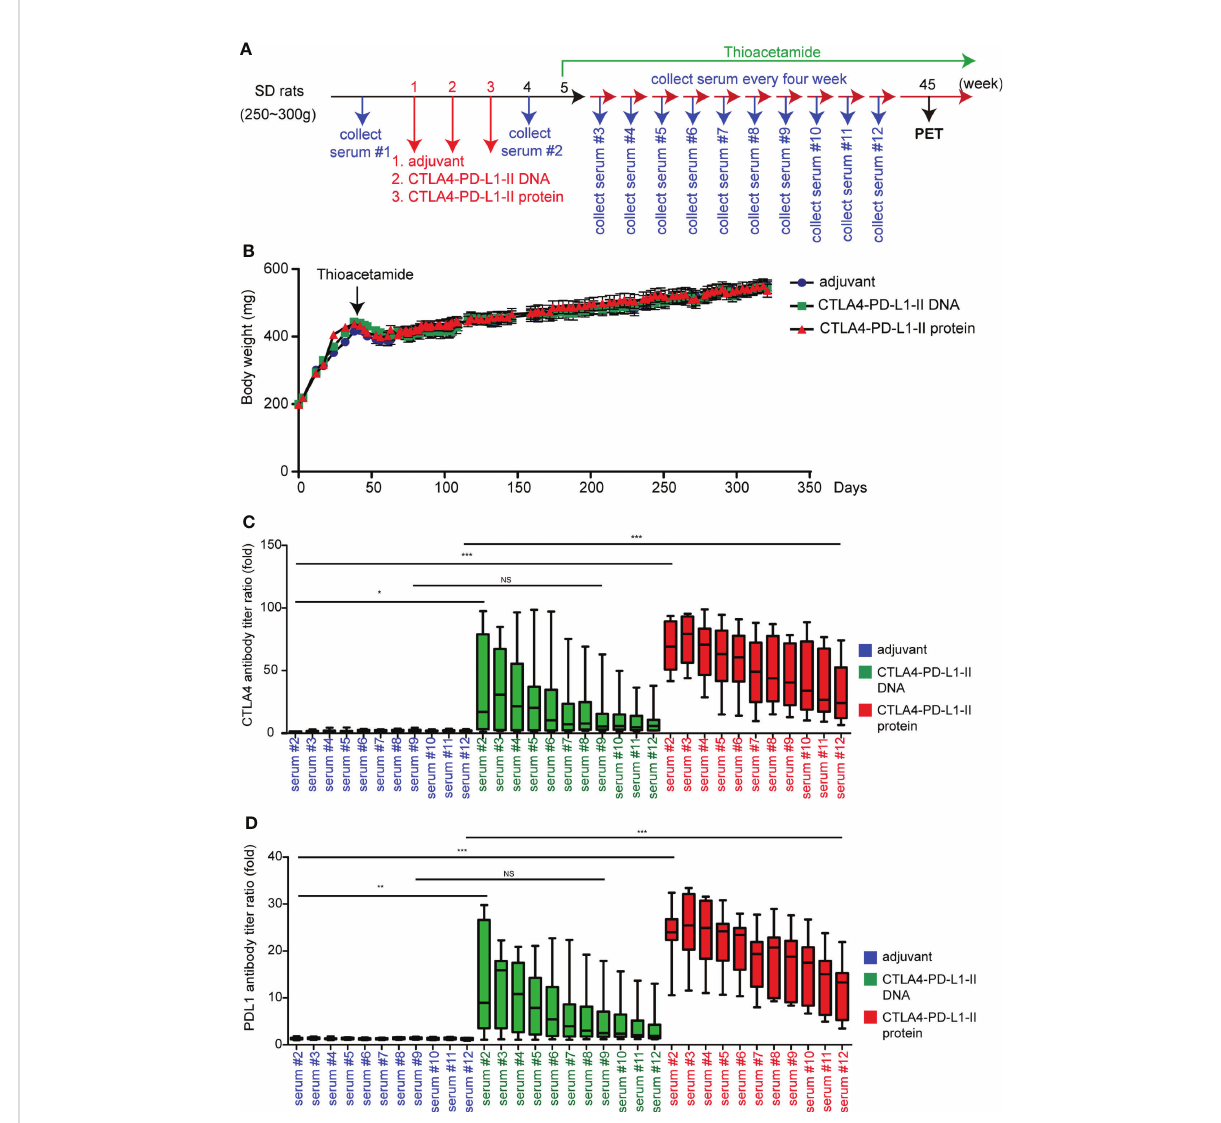
FIGURE 3 The effect of CTLA4-PD-L1-II DNA or protein vaccine. (A) A schema for experimental design for Figure 3. (B) The average body weight of rats (N=9) receiving CTLA4-PD-L1-II DNA, protein vaccines, or control adjuvant (Freund ’ s adjuvant). (C, D) The antibody titers of CTLA4 (C) or PD-L1 (D) were determined after one week (serum #2) of CTLA4-PD-L1-II DNA (DNA), CTLA4-PD-L1-II protein (protein, or control adjuvant, and the antibody titers detected every four weeks for another 40 weeks (serum #3 – serum #12). N=9. Box-and-whisker plots show the data distribution: maximum, upper quartile, median, lower quartile, and sample minimum. *P< 0.05, **P< 0.01, ***P< 0.001 by Student ’ s t -tests. NS, not signi fi